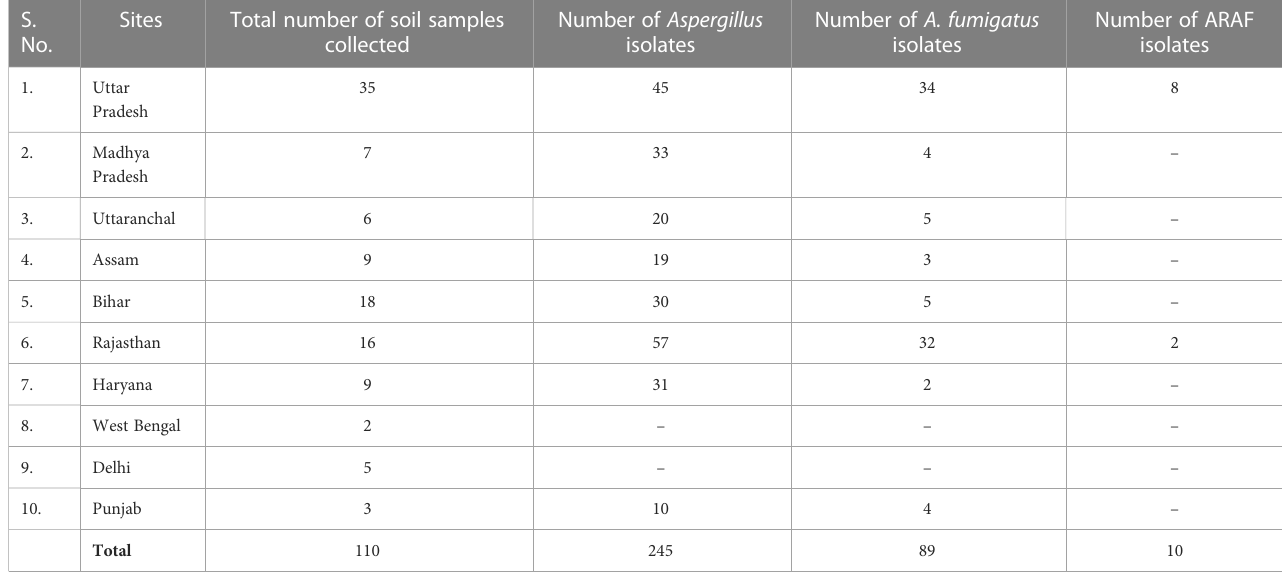
TABLE 2 Environmental ARAF isolates (identi fi ed macroscopically and microscopically) obtained from the soil samples collected from different regions of India. S.